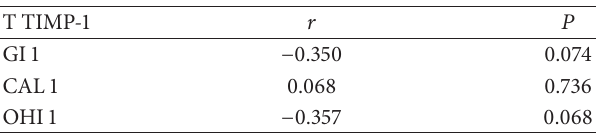
Table 4: Correlation of periodontally diseased TIMP-1 levels with clinical parameters namely gingival index, clinical attachment level, and oral hygiene index one month after nonsurgical periodontal therapy.